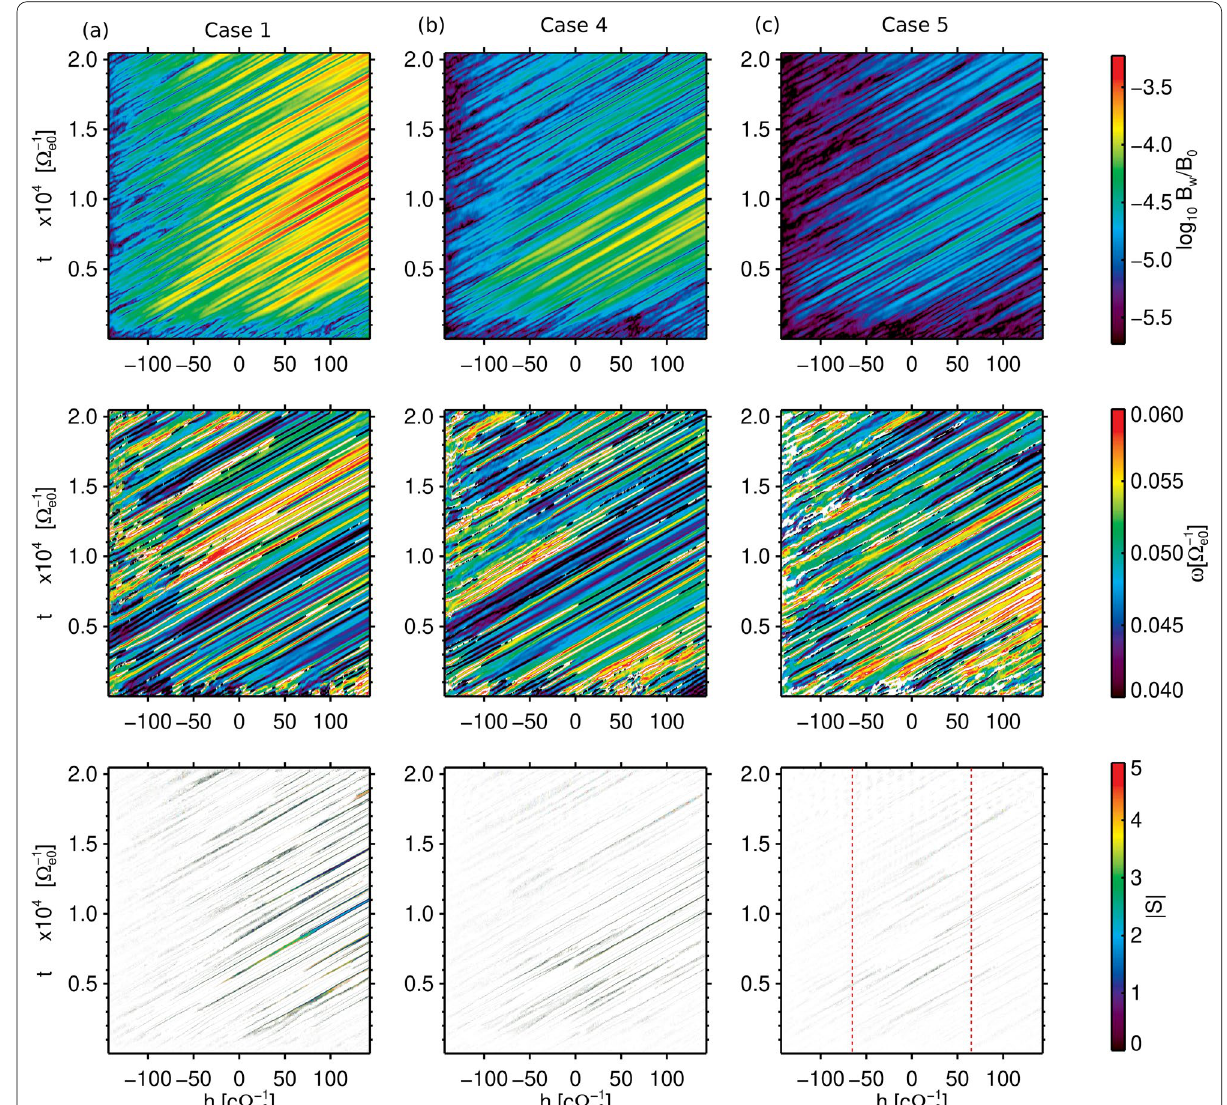
Fig. 11 Spatial and temporal evolution of wave amplitudes (top panels), instantaneous frequencies (middle panels) of forward-propagating waves ( t = 0 ∼ 2.04 × 10 4 [ (cid:31) − 1 e 0 ] ) that are after the band-pass filter of 0.04 ∼ 0.06 (cid:31) e 0 , and their corresponding S values (bottom panels). Column a corresponds to Case 1 ( ω ph = 0.3 � e 0 ); column b corresponds to Case 4 ( ω ph = 0.15 � e 0 ); column c corresponds to Case 5 ( ω ph = 0.075 � e 0 ). The red dashed lines represent the critical distance in Case